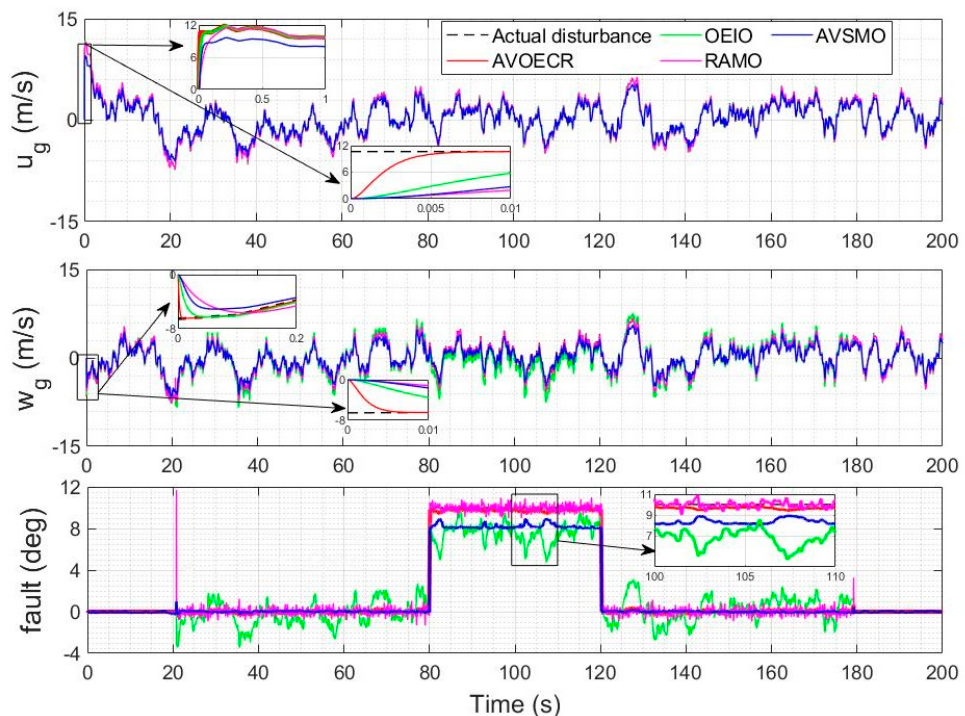
Figure 13. Actual and estimated wind velocities and actuator fault using observer-based compensa- tion with all observers (allowing higher gains for alternative